Question: Write a caption explaining this figure to a reader.
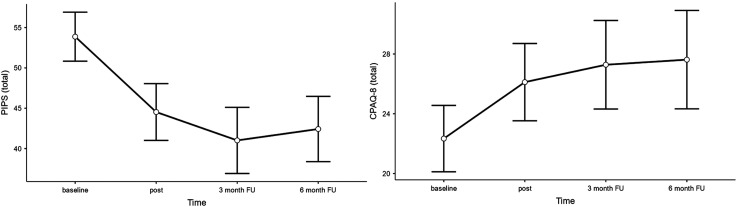
Answer: Plots depicting predicted means across time points in process outcome measures psychological inflexibility in pain (PIPS) and pain acceptance (CPAQ-8).